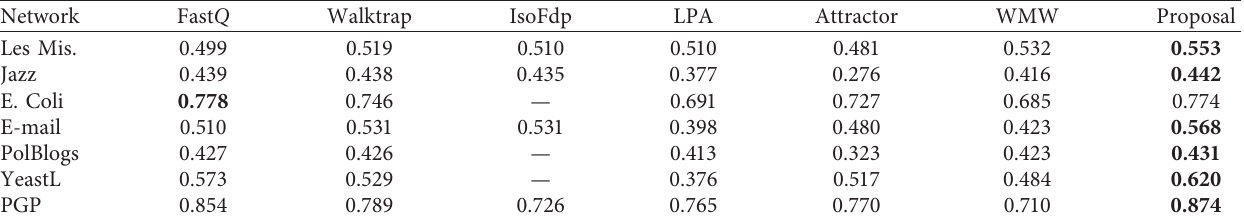
Table 4: The modularity detected from networks without ground-truth community structures by comparison algorithms and the proposed